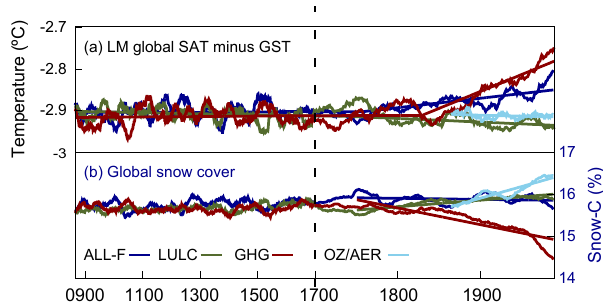
Figure 15. (a) LM evolution of the global SAT–GST offset for the ALL- F 2 , LULC 1 , GHG 1 and OZ/AER 1 simulations. Straight lines indicate the long-term trend during the LM from a two-phase re- gression analysis except for the OZ/AER 1 results that indicate a linear trend in the industrial period. The bottom panel illustrates the LM evolution of global snow cover percentage for the same ensem- ble members. Straight lines indicate the long-term trend within the 1750–2005 period except in the case of OZ/AER that only covers the 1850–2005 period. The period from 1750–2005 was selected in order to match the time span when the SAT–GST offset experiences the variation in the ALL- F 2 simulation. All series are 31-year mov- ing average filter outputs. Note the change in timing on the x axis after